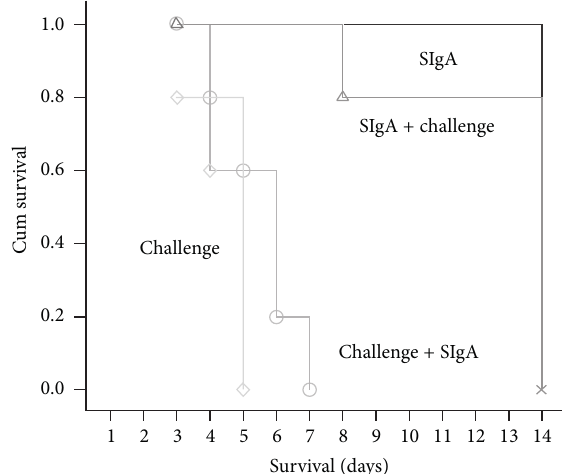
Figure 6: Survival analysis of BALB/cmice with different treatment. Kaplan-Meier survival analysis was used to determine the survival probability among the different groups. Mean survival days of the mice in Group 1 (SIgA + Challenge) was 12 ± 1 days versus 5 ± 1 days in Group 2 of Challenge + SIgA ( 𝑃 < 0.0001 ). 𝑛 = 8